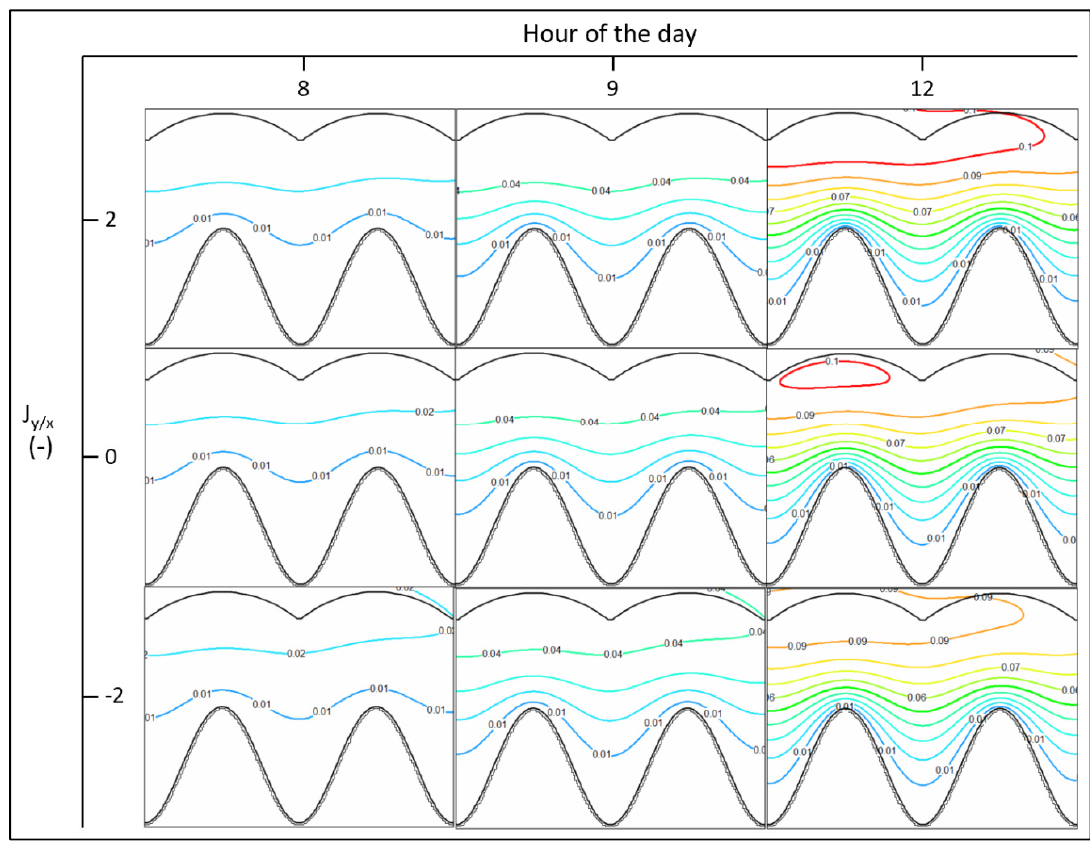
Figure 9. Snapshots of drawdown (m) at different h of the day, as a function of regional groundwater flux ( J y/x ; positive for gaining, negative for losing) (rows). All snapshots came from simulations with ET max values of 80 mm/day. Drawdown values are relative to the head values from the first h of the day of each respective simulation.